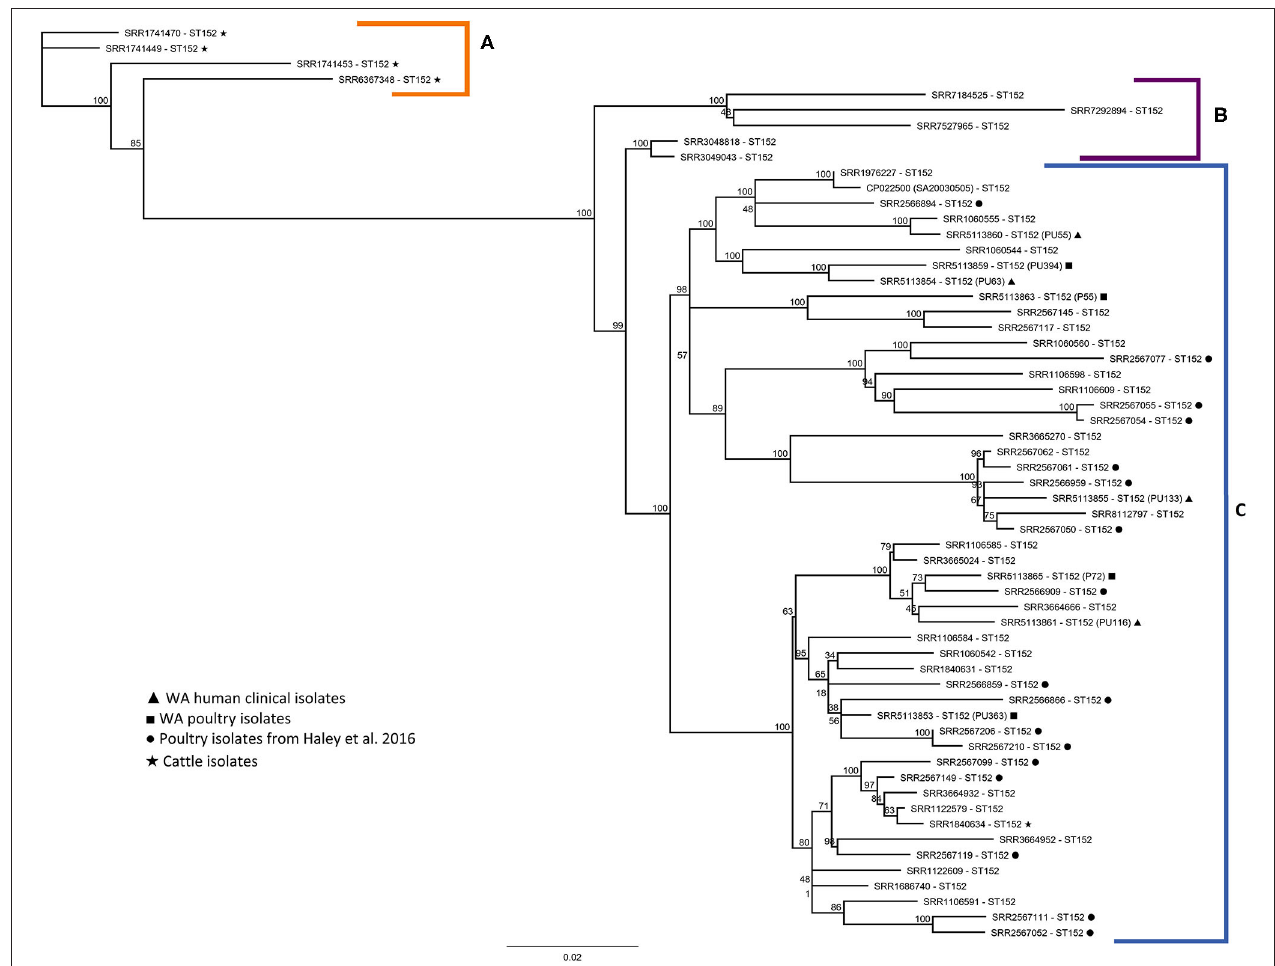
FIGURE 2 | Phylogenetic tree of S. Kentucky ST152. Maximum-likelihood phylogenetic tree based on core-genomic SNPs in S. Kentucky ST152 strains mapped to the genome of ST152 reference strain SA20030505 was generated using PhyML. Branch names are labeled by NCBI SRA identifiers; metadata for strains are included in Supplementary Table 1 . Clades (A) (orange), (B) (purple), and (C) (blue). Bootstrap values represent the percentage of concurring bootstraps from 100 iterations.